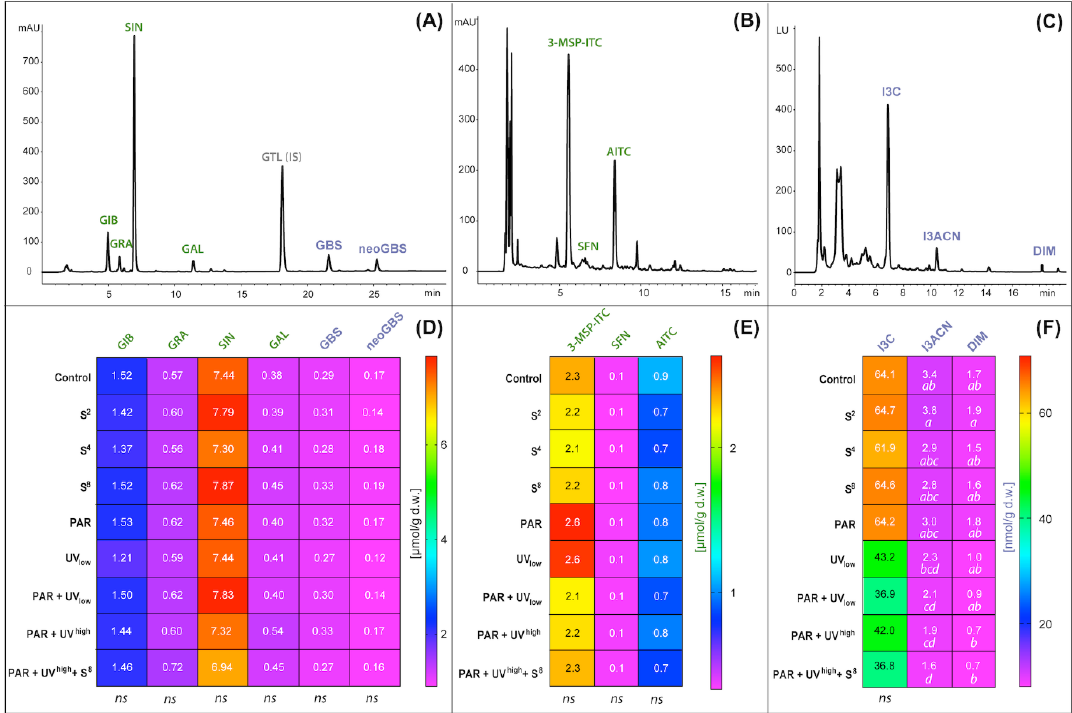
Figure 4. Sample chromatograms of ( A ) desulfo-glucosinolates ( λ = 229 nm), ( B ) ITC-NAC conjugates ( λ = 272 nm), and ( C ) indolic compounds (ex./em.: 280/360 nm) obtained from HPLC analysis of untreated reference white cabbage leaves (Ref), combined with the contents of ( D ) individual glucosinolates, ( E ) isothiocyanate, and ( F ) indole determined in treated and untreated white cabbage samples. Treatment codes are given in Table 1. The name of analytes are abbreviated as follows: GIB, glucoiberin; GRA, glucoraphanin; SIN, sinigrin; GAL, glucoalyssin; GTL(IS), glucotropaeolin (internal standard); GBS, glucobrassicin; neoGBS, neoglucobrassicin; 3-MSP-ITC, 3-(methylsulphinyl)propyl isothiocyanate; SFN, sulforaphane; AITC, allyl isothiocyanate; I3C, indole-3-carbinol; I3ACN indole-3-acetonitrile; DIM 3, 3′ -diindolylmethane. The results marked as ns , not significant, refer to a comparison of the parameter given in this column by ANOVA for all treatments and control (P ≤ 0.05). Numbers followed by the same letters within one column/parameter are not significantly different according to Tukey’s multiple comparison test at P ≤